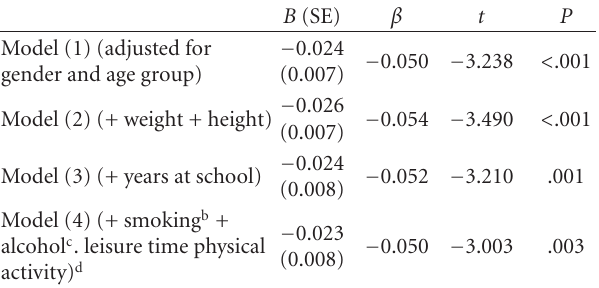
Table 3: Four di ff erent linear regression models of the association between the Dietary Index a and distal bone mineral density, as in- fluenced by increasing number of possible confounding variables.